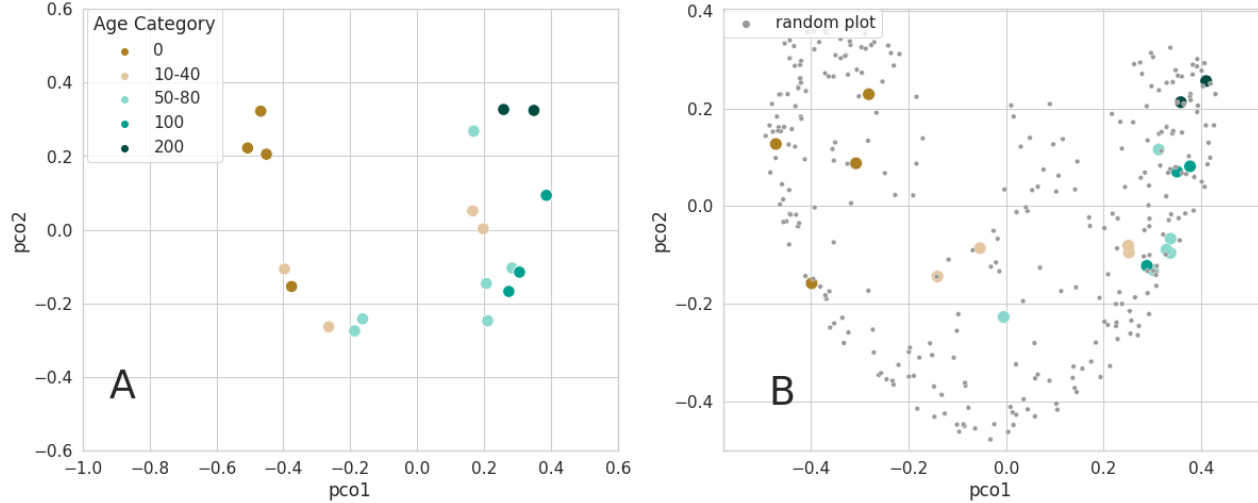
Figure 7. Projection of the plots using the PCoA components as ordination technique for BC : ( A ) the dissimilarity matrix derived from a plot network only, using the original plot boundaries; ( B ) biodivMapR elementary surface units overlapping the plots’ inaccessibility poles were used. All the elementary units from the northern range of Trinidad were used as an input to the PCoA (shown in gray).